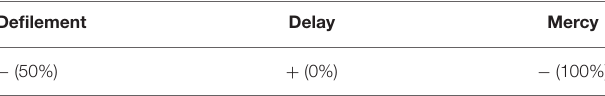
TABLE 1 | The probabilities resulted from neglecting the half-dead stranger with leprosy a . Defilement